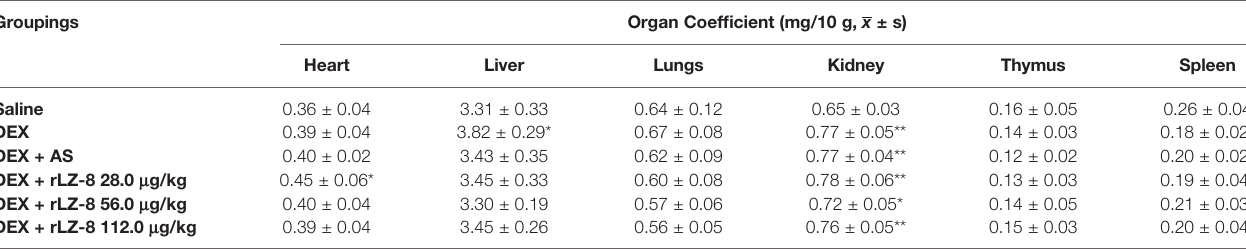
TABLE 2 | Results of Various Organ Coef fi cient in Rats (n = 10, g/100 g BW). Groupings